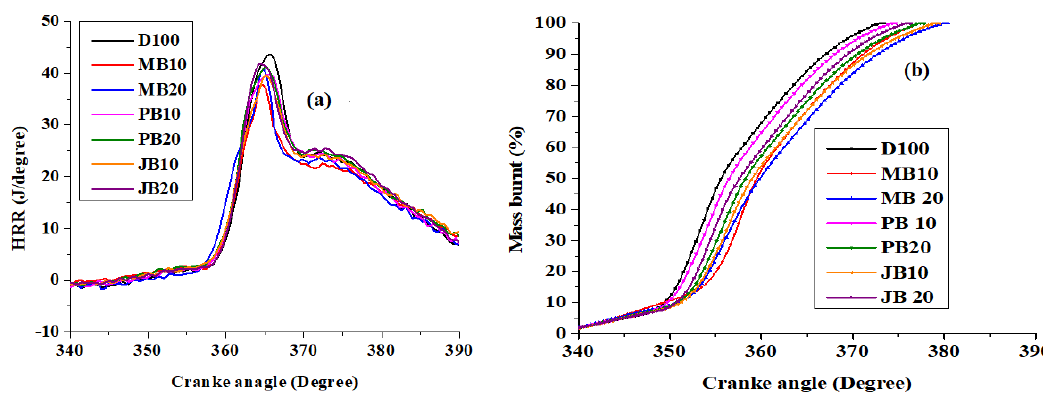
Figure 5. ( a ) Heat release rate profiles with diesel, microalgae, polanga, and jatropha biodiesel blends at 100% load. ( b ) Mass fractions burnt in the engine with diesel, microalgae, and polanga biodiesel blends at 100% load.